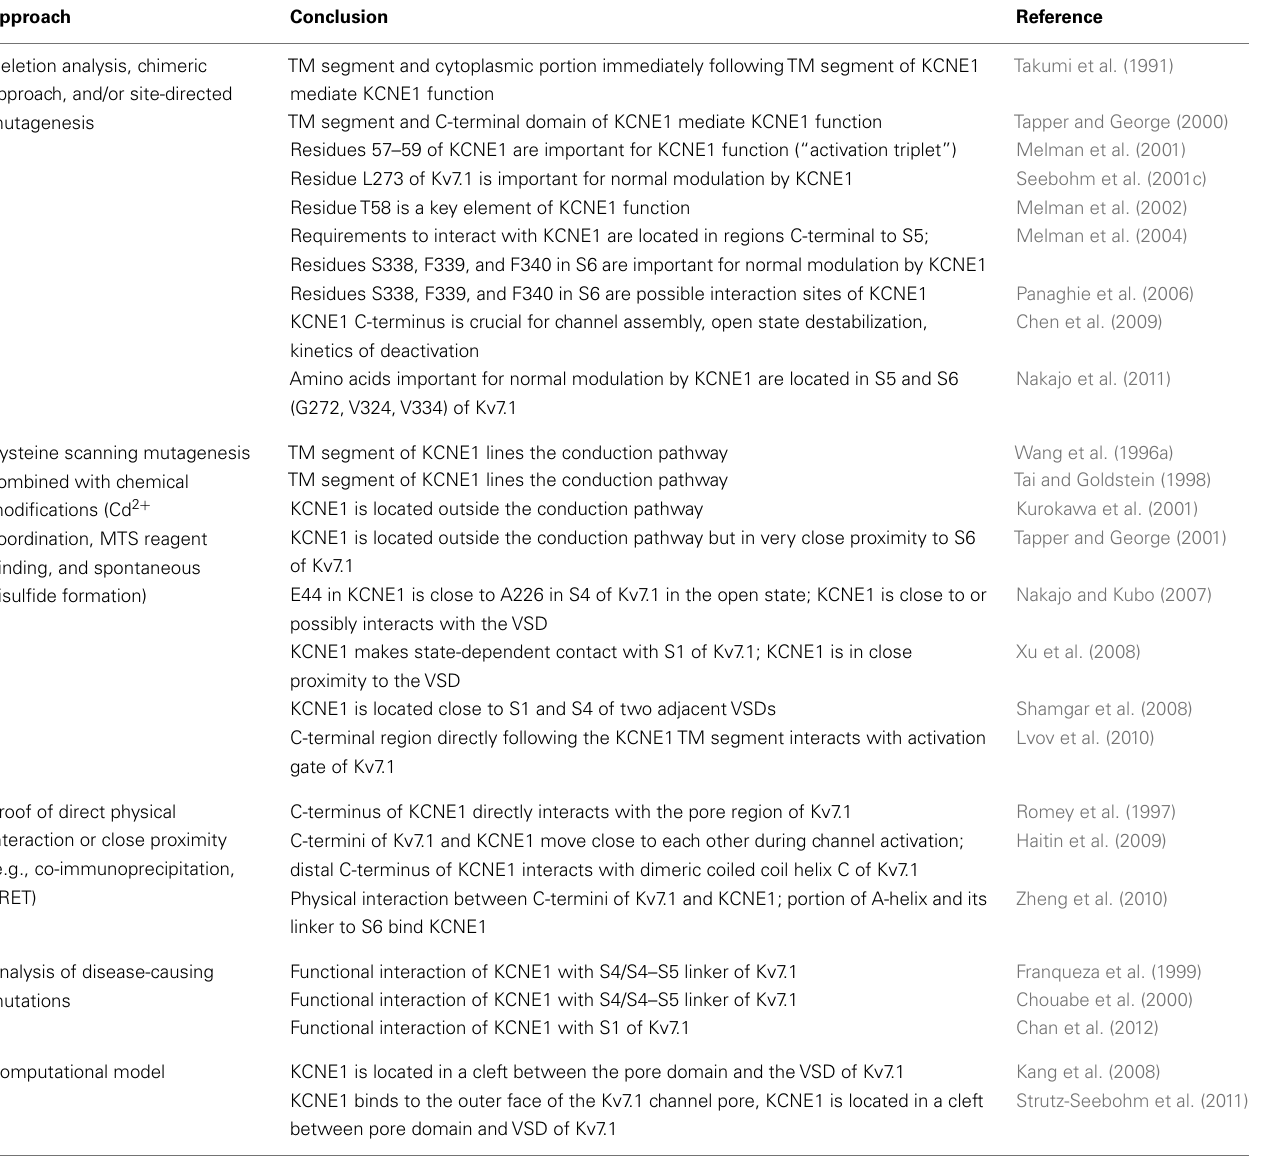
Table 2 | Structural basis of Kv7.1/KCNE1